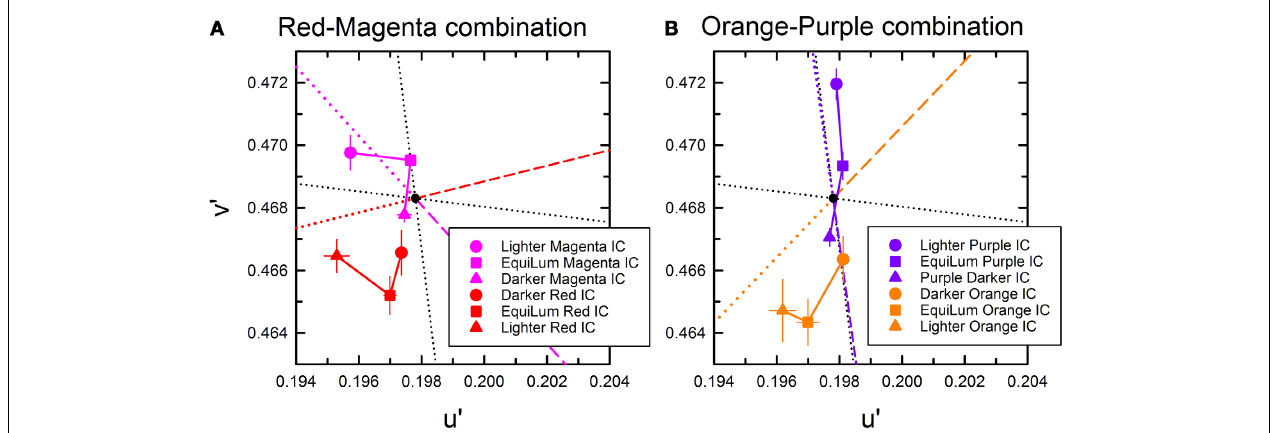
FIGURE 7 | Results of Experiment 3 plotted in the CIE u (cid:2) v (cid:2) chromaticity diagram. (A) The results for the red and magenta combination and (B) those for the orange and purple combination. Different symbols are associated with different contour luminance conditions. In (A) , circles: R20/M45 (the luminance of red color was 20cd/m 2 and that of magenta was 45cd/m 2 ), squares: R33/M33